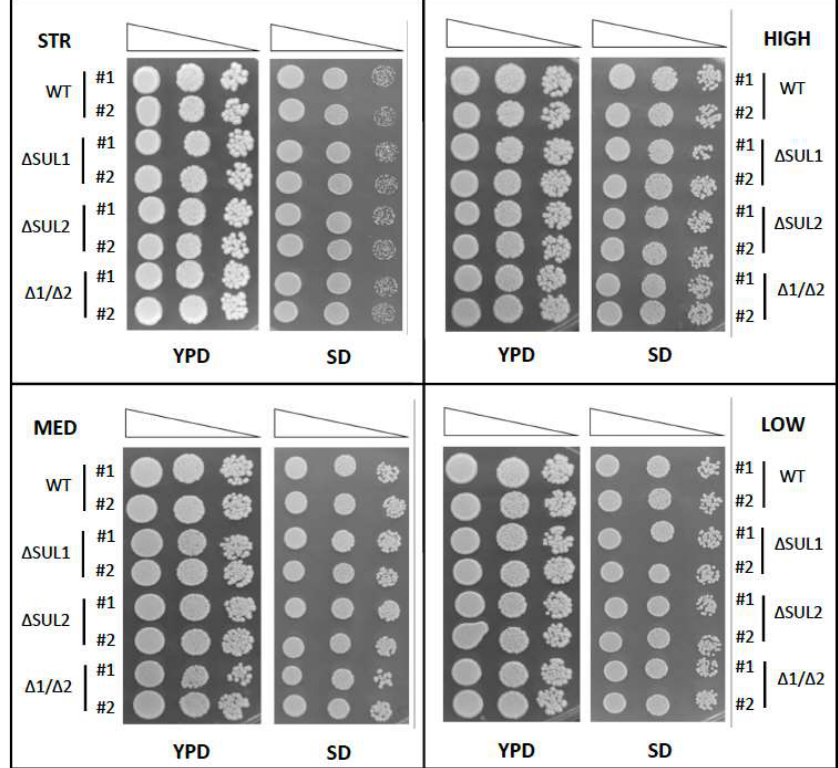
Figure 1. Viability assay of winery yeast strains carrying the deletion of SUL1 and/or SUL2 genes. Exponentially growing S. cerevisiae cells of the indicated strains (STR, HIGH, MED, and LOW) were serially diluted, spotted on rich (YPD) or minimal (SD) media plates, and incubated at 28 °C for 3 days. Two clones (#1 and #2) for each strain were compared, carrying either parental alleles (WT), deleted for SUL1 ( ΔSUL1 ), SUL2 ( ΔSUL2 ), or both genes ( Δ1/Δ2 ). Images are representative of two independent experiments.